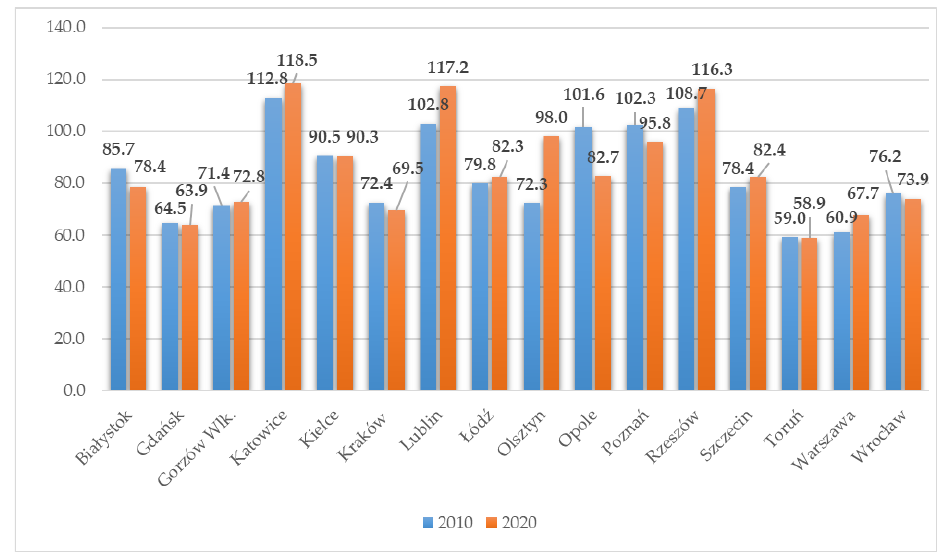
Figure 7. The hospital beds per 10,000 residents in the surveyed Polish cities in 2010 and 2020. The number of hospital beds between the surveyed cities varied quite a bit, but changed little over time. In 2010, it ranged from 59.0 (Toruń) to 112.8 (Katowice), and in 2020 it varied from 58.9 (Toruń) to 118.5 (Katowice). Unlike the number of d octors and nurses, the studied indicator did not show an upward trend in all analyzed city units. Indeed, the number of hospital beds decreased in: Białystok, Kielce, Kraków, Opole, Toruń and Wrocław. On the other hand, the largest increase in hospital inf rastructure was recorded in Lublin and Olsztyn. The declining number of hospital beds may be due to the shrinking population. Nevertheless, it should be borne in mind that the elderly population